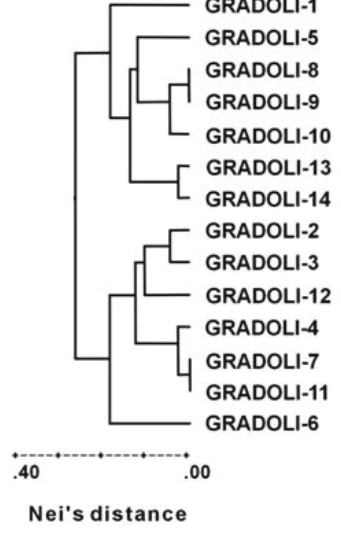
Figure 4. UPGMA dendrogram of 14 ‘Fagiolo del Purgatorio’ from Gradoli populations based on SSR molecular